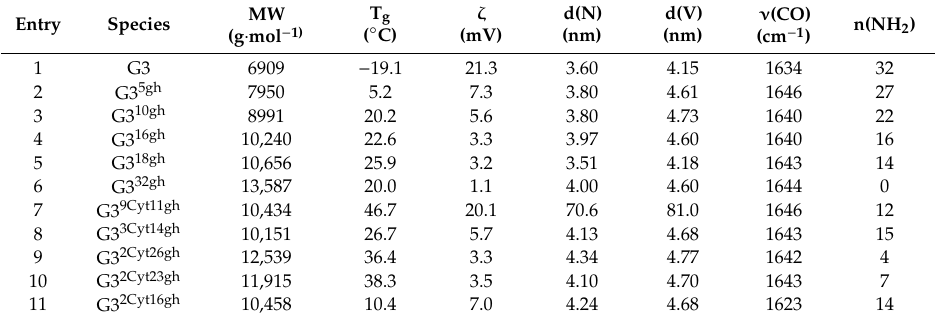
Table 2. Properties of G3 Cgh conjugates: The average molecular weights (MW) were calculated based on the conjugate stoichiometry estimated by 1 H-NMR spectroscopy. The values of ζ potential and number- and volume-averaged diameter of conjugate molecules (d(N) and d(V), respectively) were measured at pH 5. The last column shows an averaged number of non-converted primary amine groups of conjugates (n(NH 2